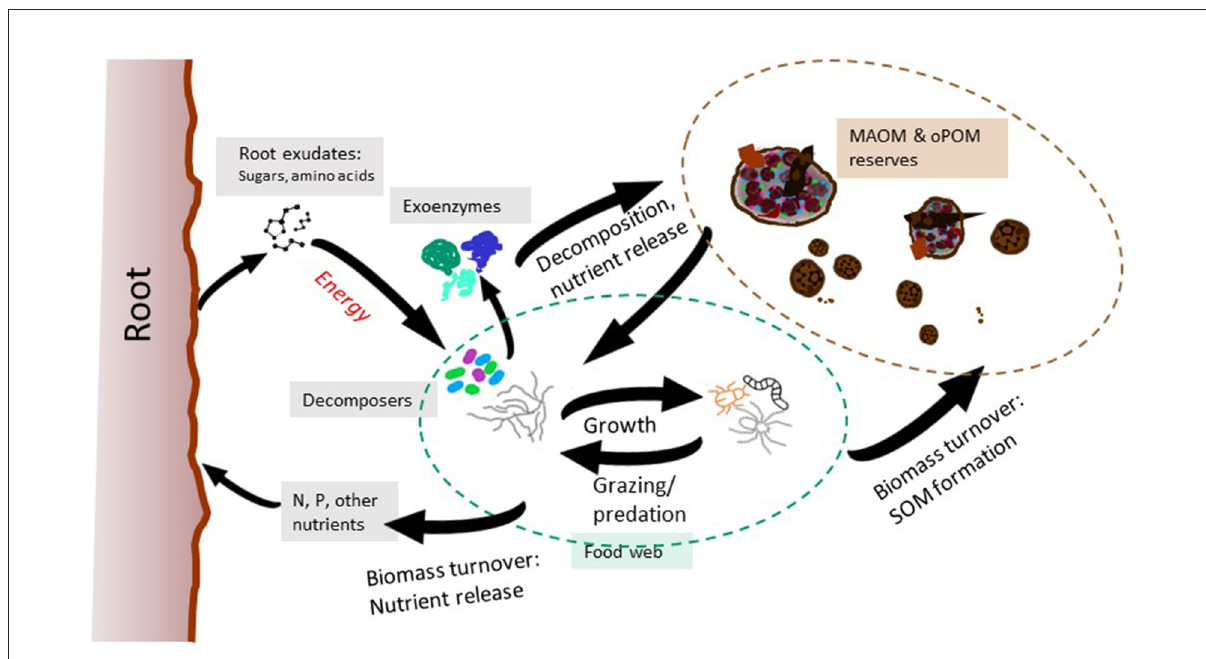
FIGURE3 In the rhizosphere, decomposition and stabilization/formation of SOM occur simultaneously. Plants exchange C substrates for nutrients released by the decomposers. Organic compounds and ions are secreted by plant roots into the rhizosphere providing energy to decomposers and enabling them to produce expensive exoenzymes needed to access nutrient rich oPOM and MAOM fueling microbial growth. The resulting microbial biomass supports grazers and predators, and these trophic interactions release N and P that can then be taken up by roots. Growth and turnover of decomposers and soil food web organisms increases the flow of necromass and replenishes oPOM and MAOM reserves. Modified after Liang et al., 2017 and Valadares et al.,